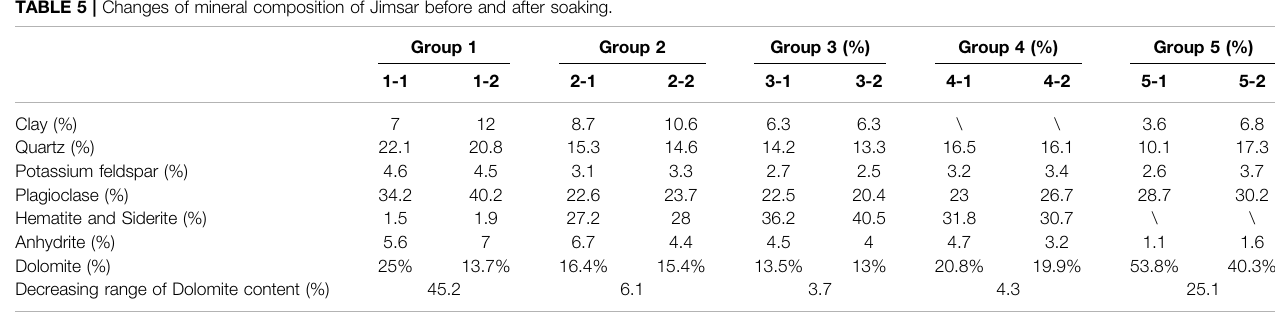
TABLE 5 | Changes of mineral composition of Jimsar before and after